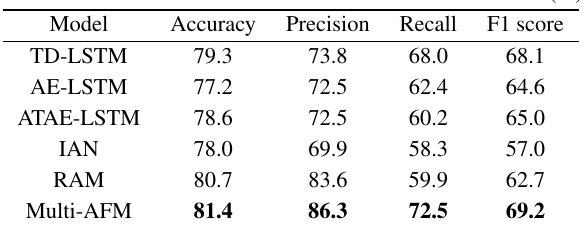
Table 4 Performance comparison of each model on Course